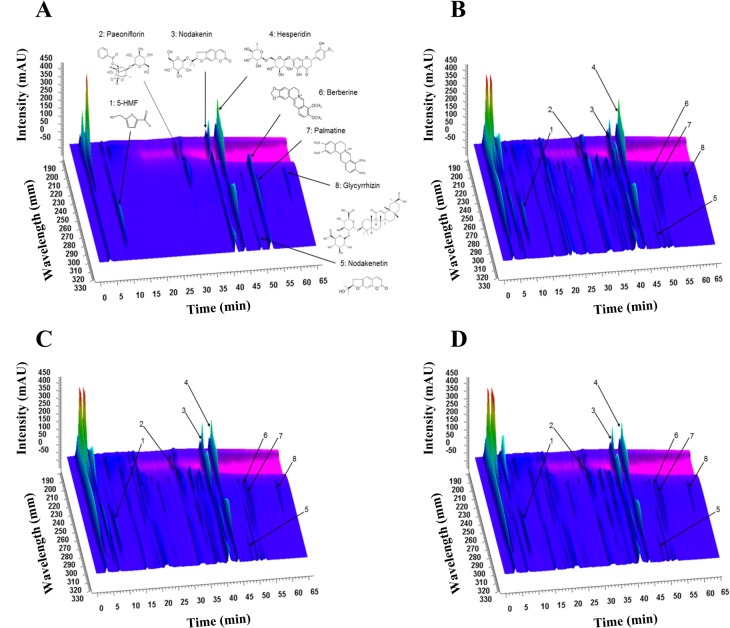
Chromatograms of eight major standard compounds in JGT, aJGT, and fJGT162, as analyzed using 3D-HPLC.Three-dimensional chromatograms of a standard mixture of eight compounds in (A), JGT (B), aJGT (C), and fJGT162 (D) at 190‒400 nm (UV). 5-HMF (1), paeoniflorin (2), glycyrrhizin (3), nodakenin (4), nodakenetin (5), berberine (6), palmatine (7), and hesperidin (8) were identified.